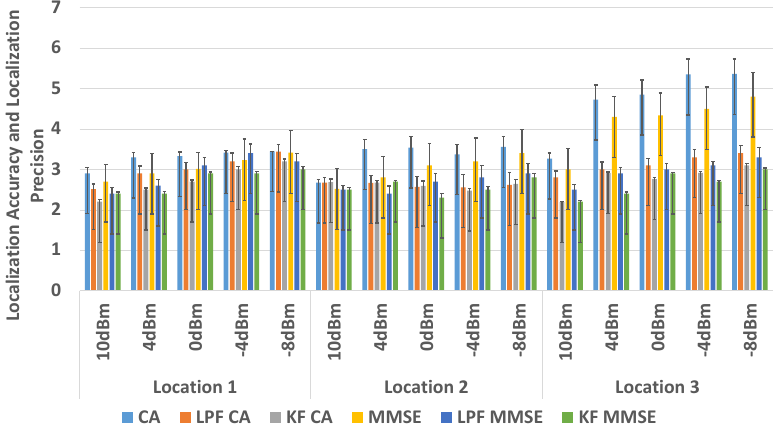
Figure 13. Comparison in Environment